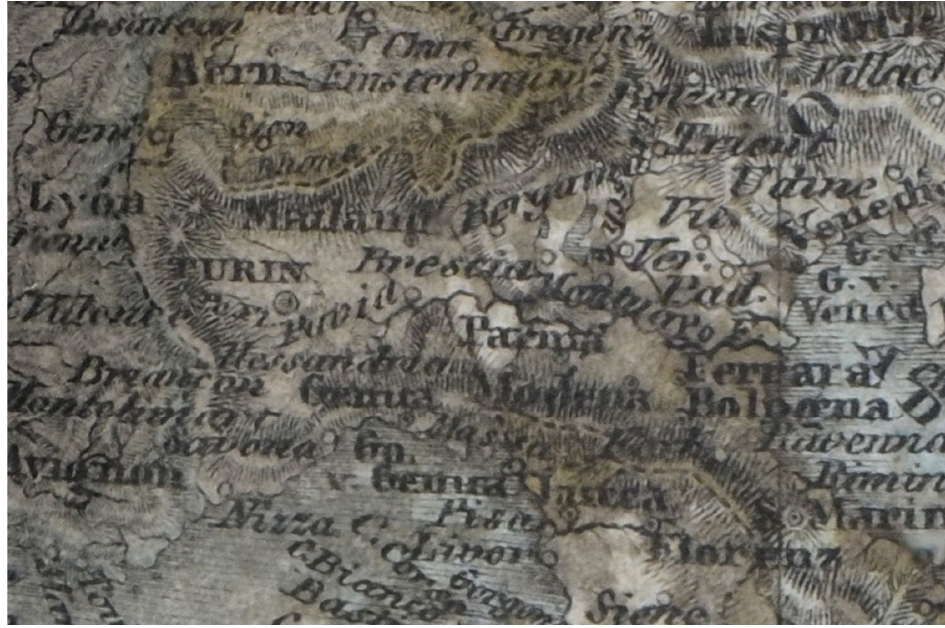
Figure 13. The example of dense description. Source: Map Collection of the Faculty of Science, Charles University.